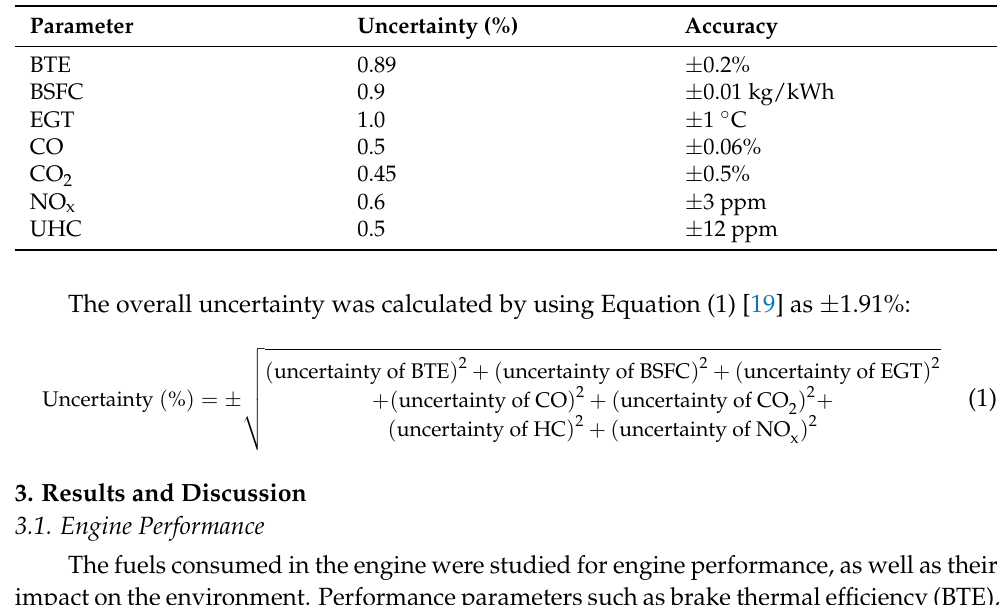
Figure 3. Schematic diagram of the experimental setup (Kirloskar TV1 engine, 1; eddy current dy-